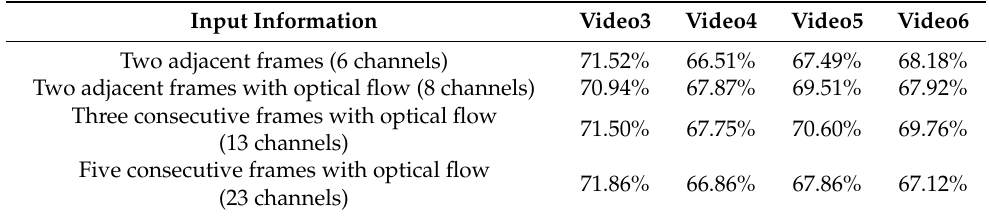
Table 7. The influence of different input information on the performance of the rough detection network.